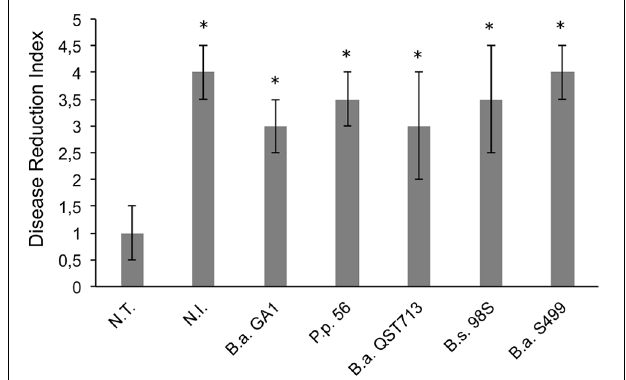
FIGURE 1 | In planta control of pathogens on seeds and seedlings. Efficiency of Bacillus strains to reduce infection by Rhizomucor variabilis was based on visual assessment after 25 days of incubation [Disease Reduction Index (DRI)]. N.T .: seeds are infected with R. variabilis and not treated with Bacillus strains; N.I .: seeds are not infected with the fungus nor treated with Bacillus strains. B.a. GA1: infected seeds treated with Bacillus amyloliquefaciens GA1; P.p 56: infected seeds treated with Peanebacillus polymyxa 56; B.a. QST713: infected seeds treated with B. amyloliquefaciens QST 713; B.s. 98S: infected seeds treated with Bacillus subtilis 98S; and B.a. S499: infected seeds treated with B. amyloliquefaciens S499. Averages and standard deviations (error bars) were calculated from four replicates per treatment and the experiment was repeated twice with similar results ( n = 8). Bars marked with an asterisk differ significantly from the non-treated but infected controls (N.T.) ( α <